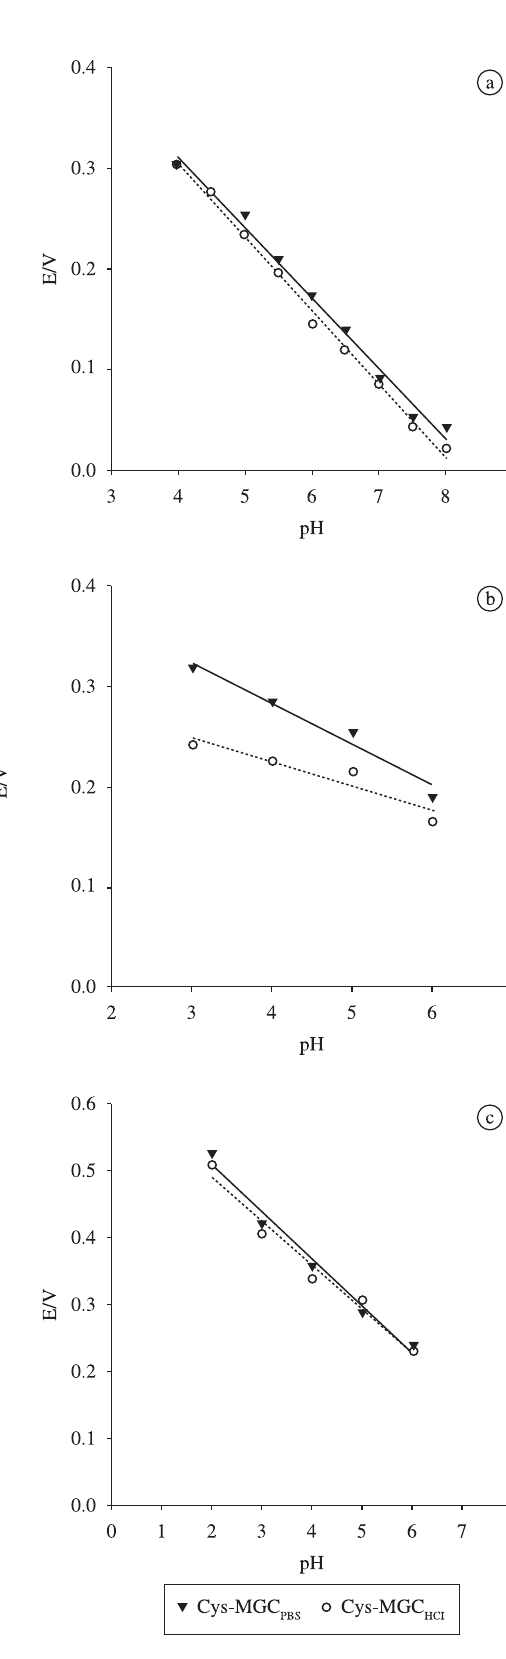
Figure 6. Effect of peak potential (Epa) of DA response as a function of pH at both modified electrodes, Cys-MGC phthalate; b) acetate and c) phosphate